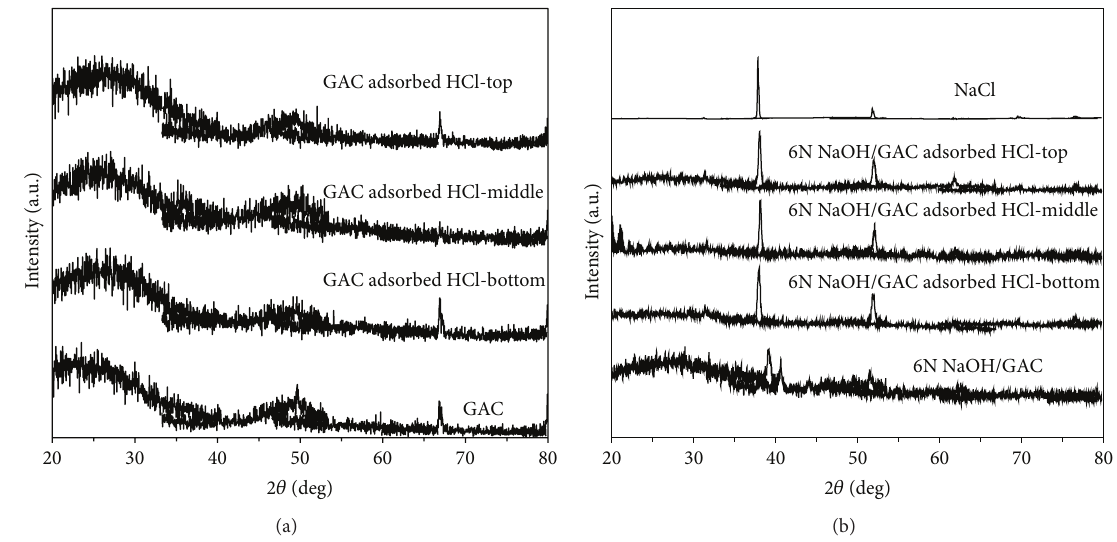
Figure 6: XRD patterns of GAC and 6 N NaOH/GAC after HCl adsorption.